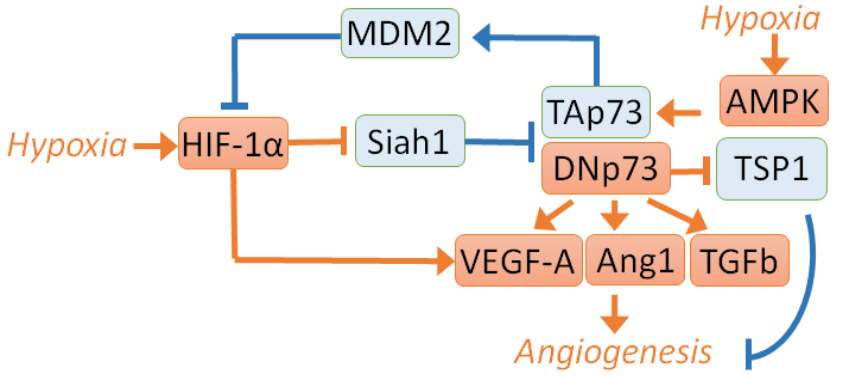
Figure 2. Regulation of angiogenesis by p73. The antiangiogenic signaling is shown in blue, and proangiogenic signalling is shown in red. TAp73 inhibits angiogenesis via MDM2-mediated degrada- tion of HIF-1 α [99], whereas the loss of TAp73 and overexpression of DNp73 results in the increased HIF-1 α activity and upregulation of proangiogenic cytokines [88]. In turn, TA- and DN- p73 iso- forms are stabilised by HIF-1 α -dependent suppression of the Siah1-mediated degradation during hypoxia [100]. Similarly, TAp73 can be stabilised by AMPK [104]. Consequently, DNp73 or TAp73 can target VEGF-A, Ang1, and TGFb to promote angiogenesis. On the contrary, TSP-1 is repressed by DNp73, which leads to enhanced angiogenesis in xenograft cancer models